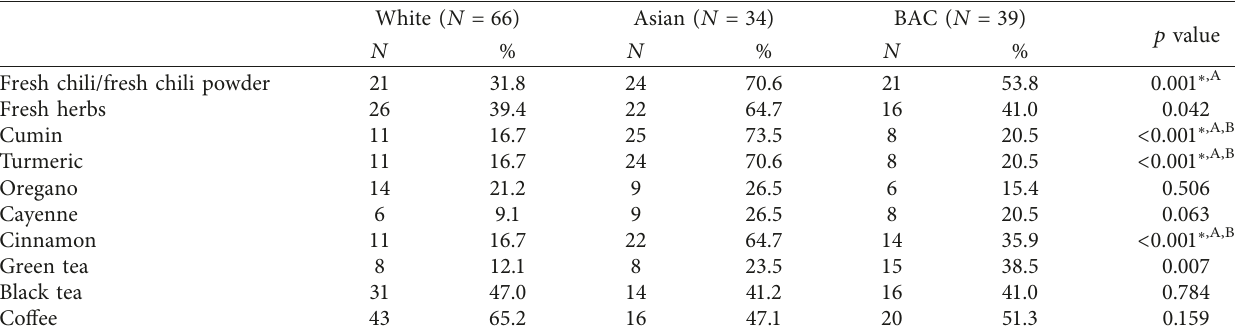
Table 4: Dietary habits including herbs and beverages such as coffee, black, and green tea between the three different ethnic groups.